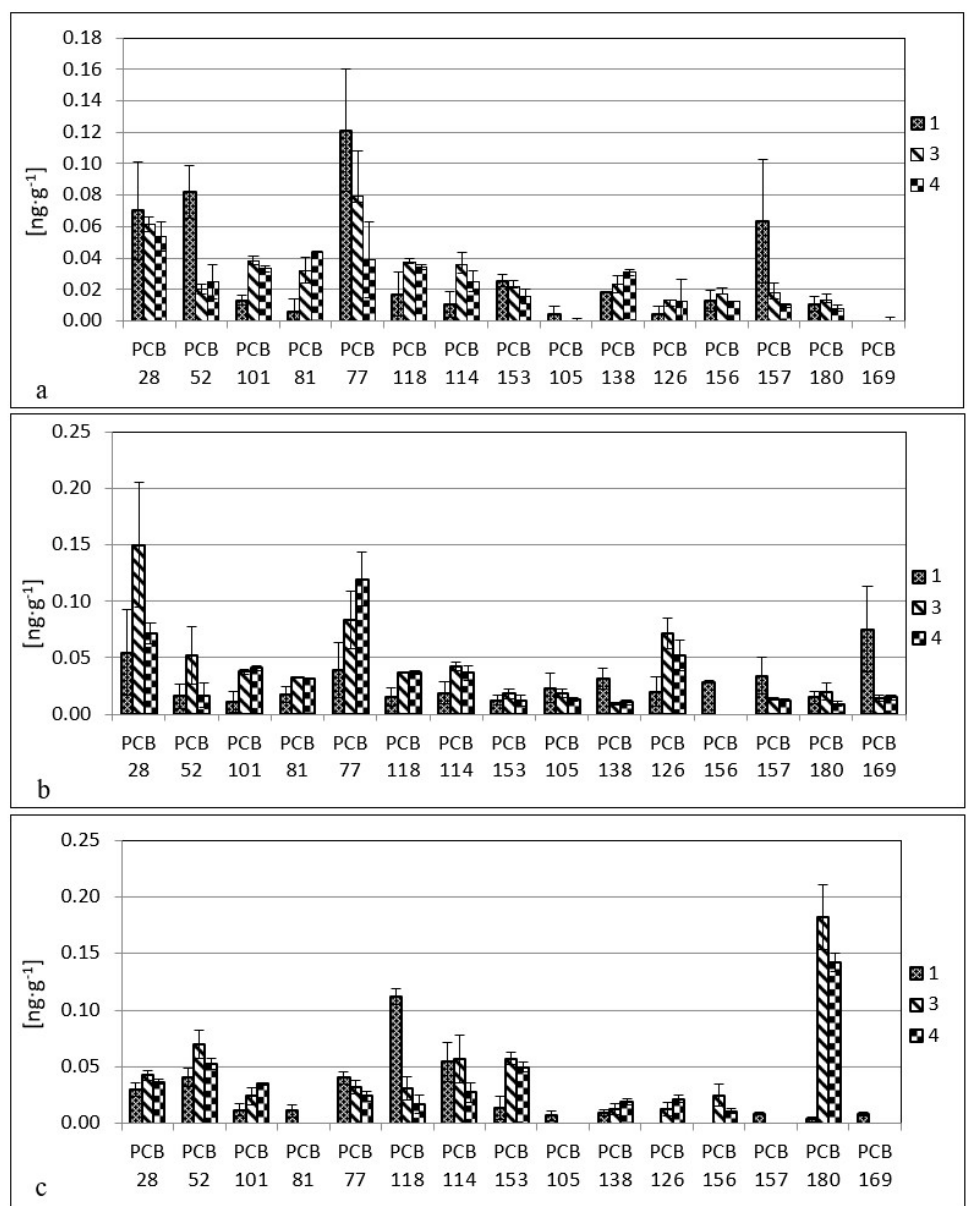
Figure 2. Comparison of PCB contents in dried fruits analyzed with methods 1, 3, and 4. ( a )—apricot, ( b )—pear, ( c )—apple; 1—determined with the specific method for PCBs; 3—determined according to the methods of Vives and Grimalt [32]; 4—determined according to the methods of Jaouen-Madoulet et al.